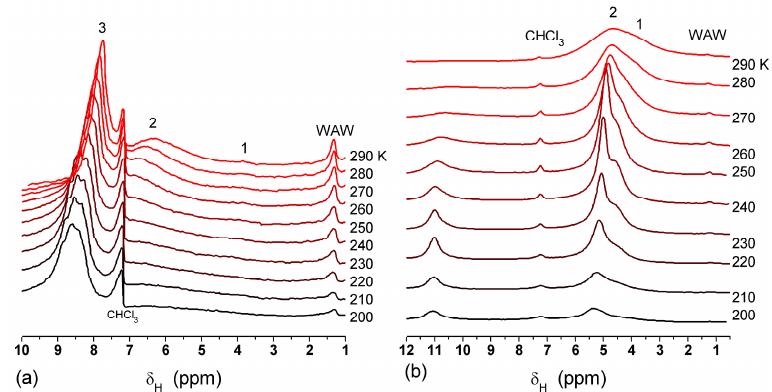
Figure 17. 1 H NMR spectra of CM1 with adsorbed aqueous solutions (150 mg/g) of ( a ) 18% HCl and ( b ) 16% H 2 O 2 in CDCl 3 medium.